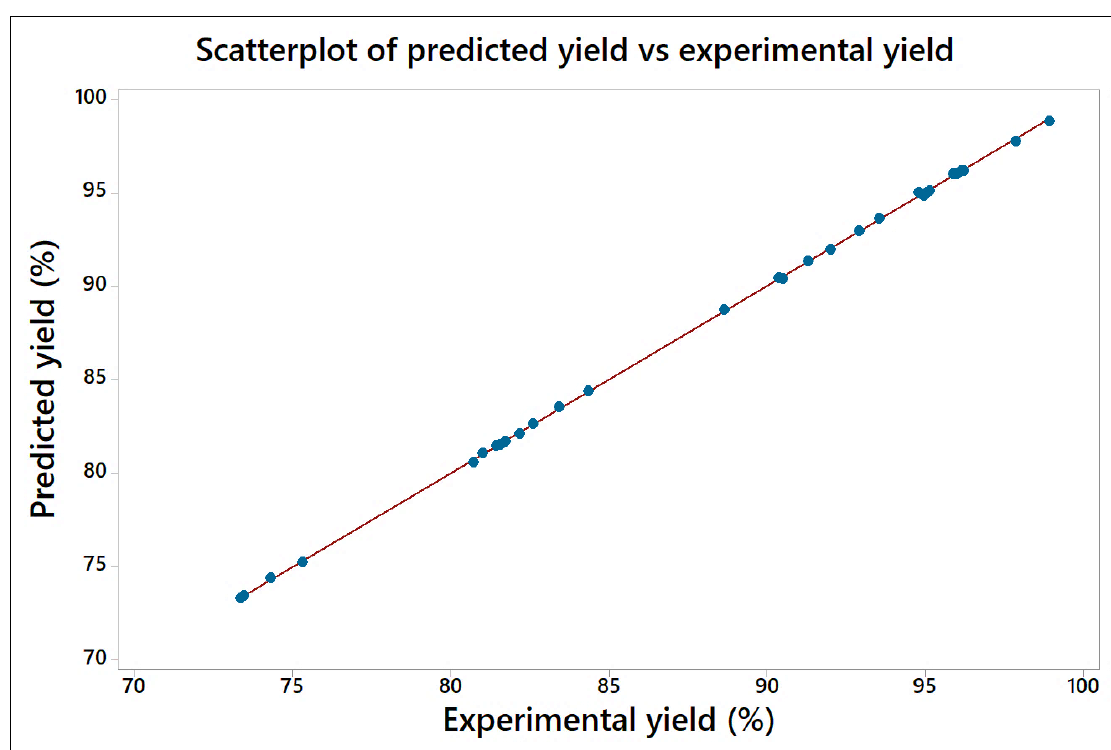
Figure 27. Comparison between the experimentally derived yield and that of the predicted values for the transesterification process of WCO as per the design matrix obtained from the CCD model.